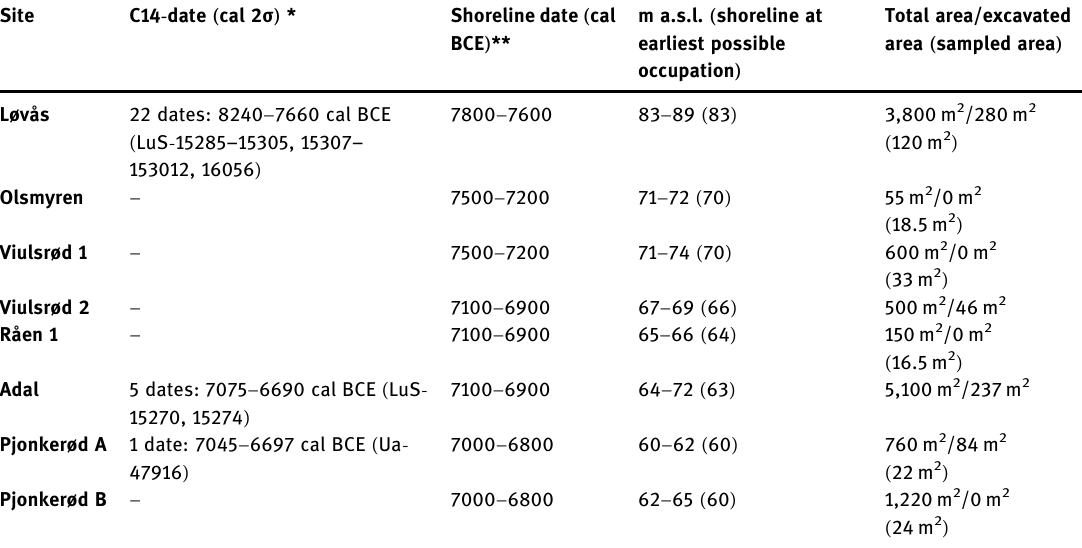
Table 1: Key data for Middle Mesolithic sites discussed in the article. For site locations, refer Figure 1